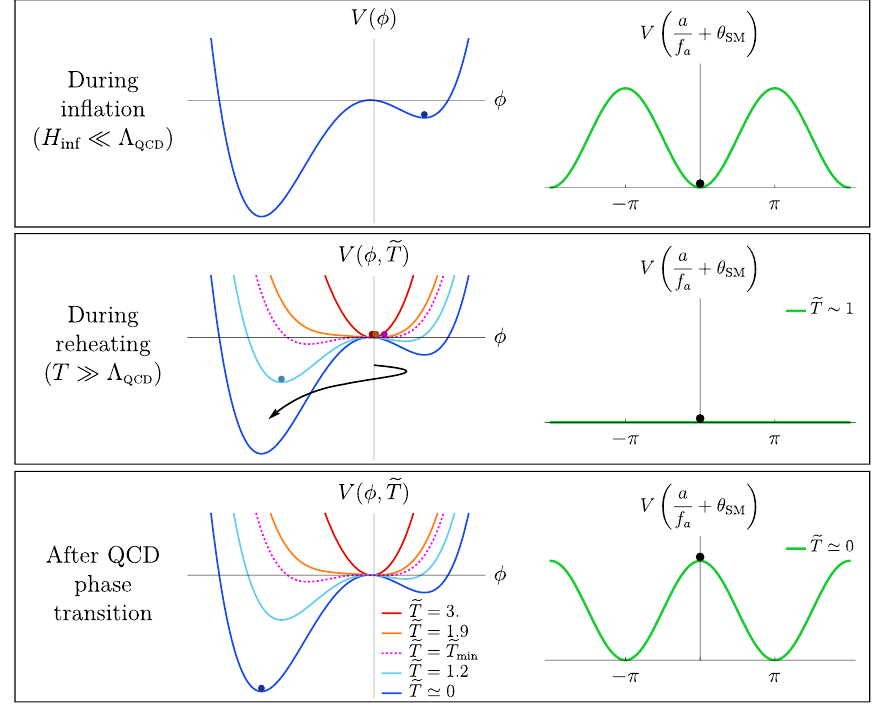
Figure 4 . Figure analogous to (cid:12)gures 1 and 3, for the case in which (cid:30) lies the false vacuum during in(cid:13)ation and rolls to the false vacuum at the beginning of the thermal phase. At a temperature around e T min (see (cid:12)gure 5), for which V ( (cid:30); e T min ) is marked with a dashed magenta line, the false vacuum is unstable against thermal decay, and (cid:30) ends up in the true vacuum today. Also in this case, the VEV of (cid:30) changes sign between the in(cid:13)ationary time and